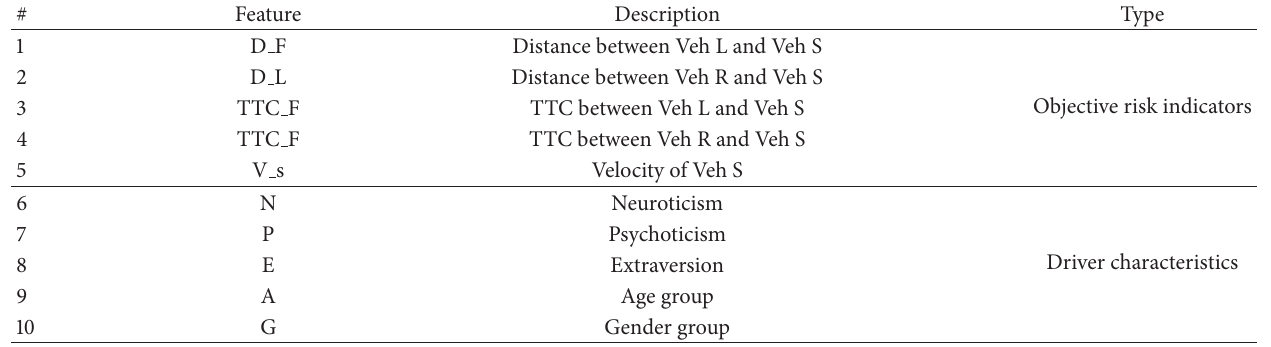
Table 3: Candidate features (calculated based on the start time of the cut-in vehicle movement).